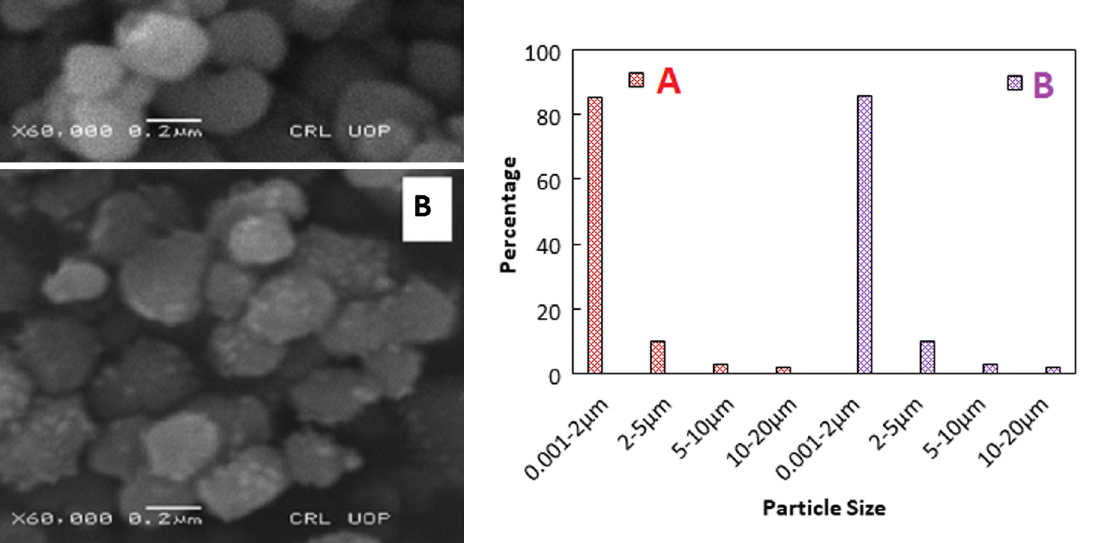
Figure 2: Scanning electron micrographs: (a) TiO